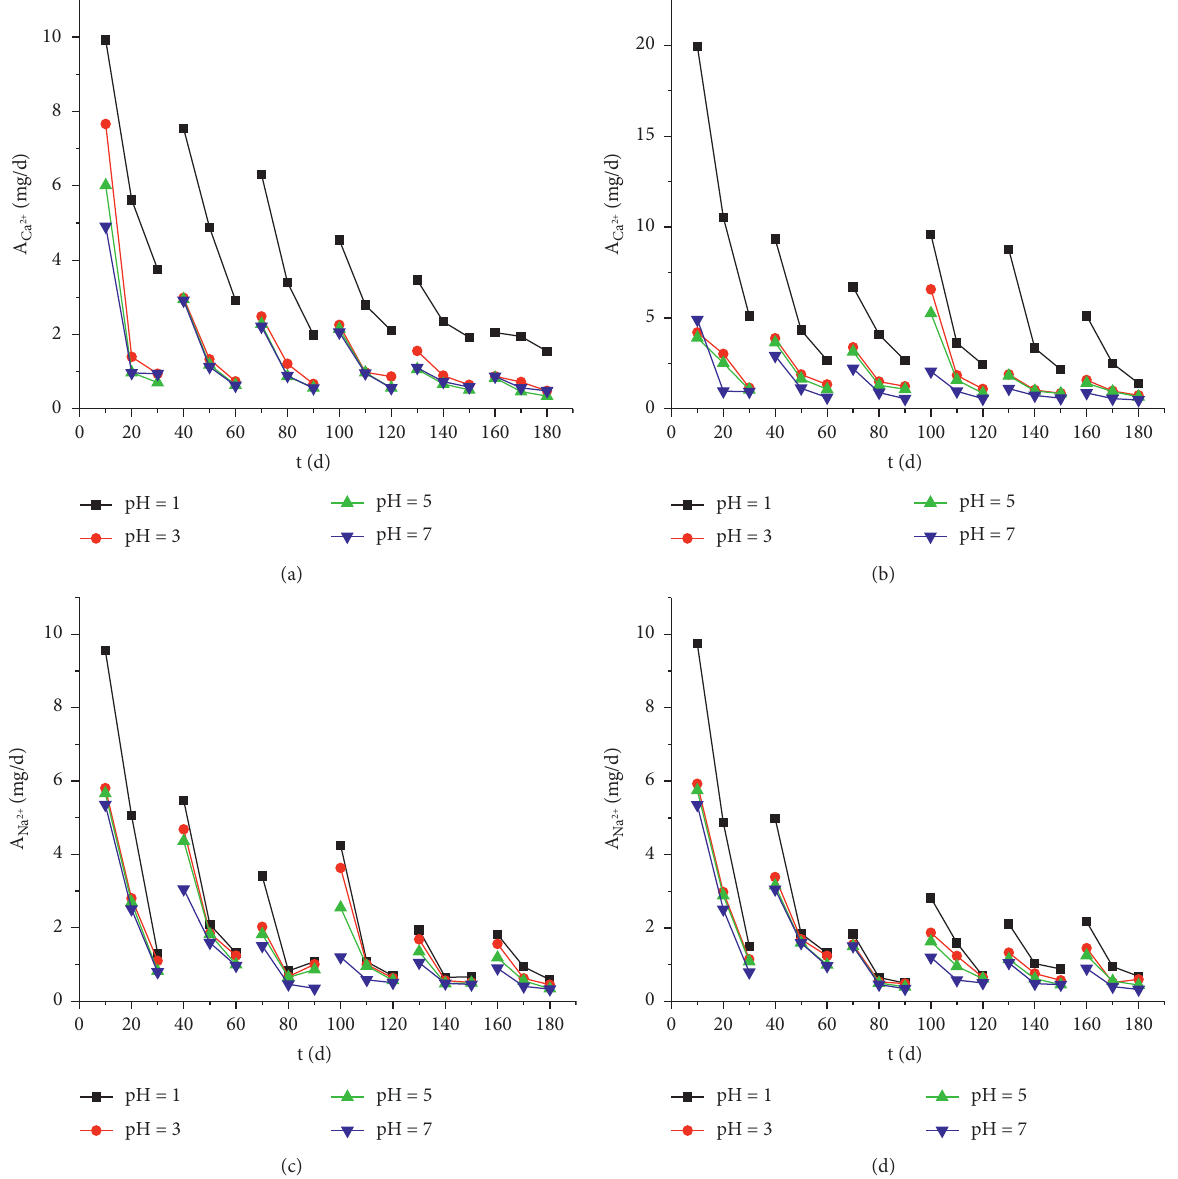
Figure 7: The change law of cation dissolution rate with time in different chemical solutions: (a) Ca 2+ in sulfuric acid solution, (b) Ca 2+ in hydrochloric acid solution, (c) Na + in sulfuric acid solution, and (d) Na + in hydrochloric acid